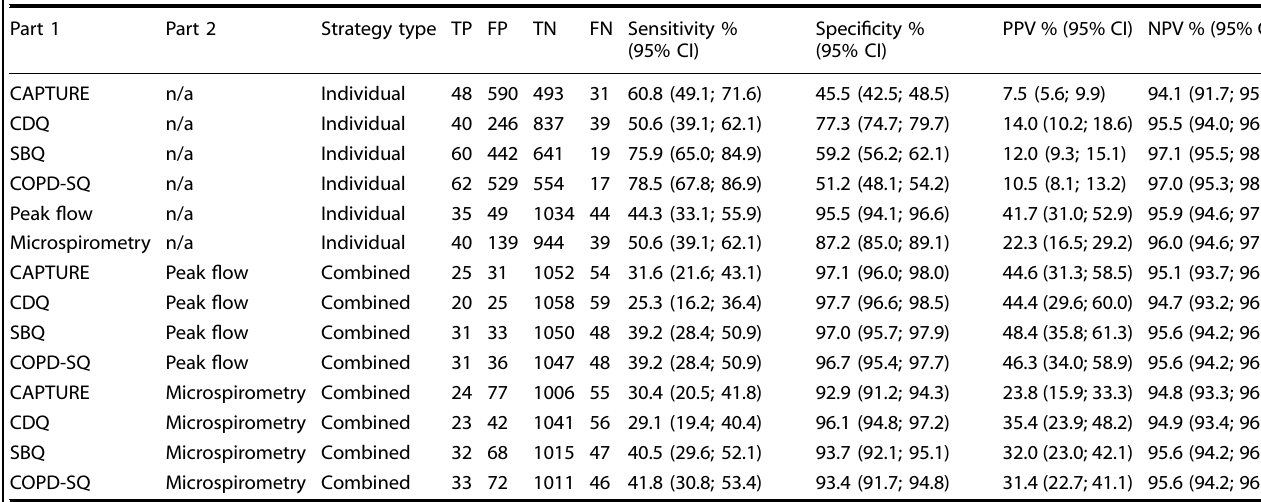
Table 2. Accuracy of index tests and test